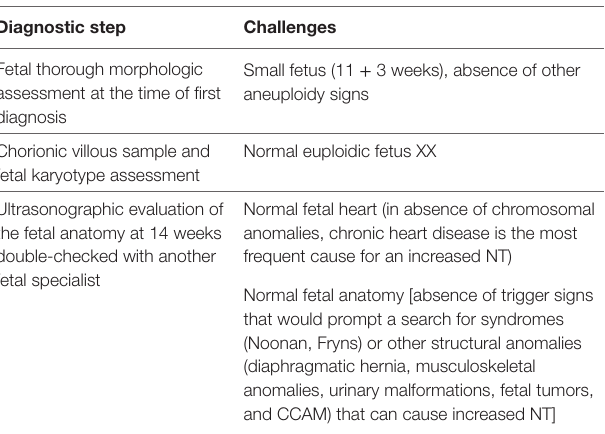
taBLe 1 | The diagnostic steps and challenges.